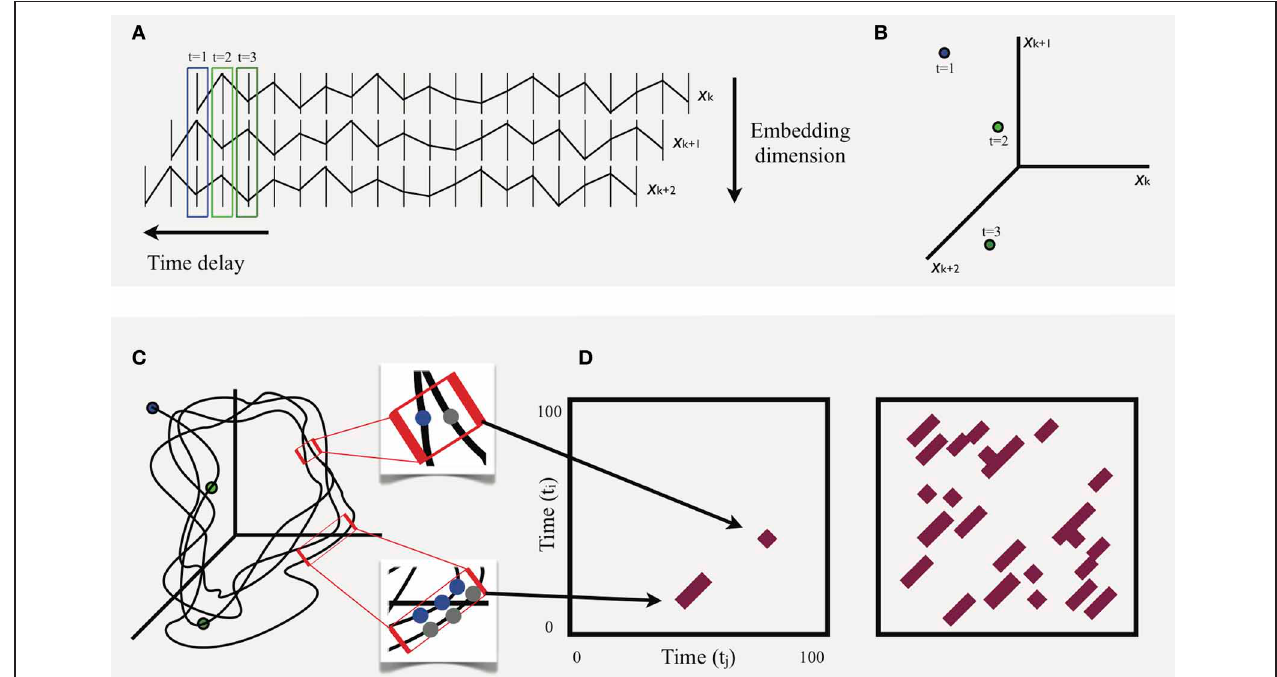
FIGURE 1 | Schematic illustration of the basic procedure of recurrence quantification analysis using a hypothetical example.